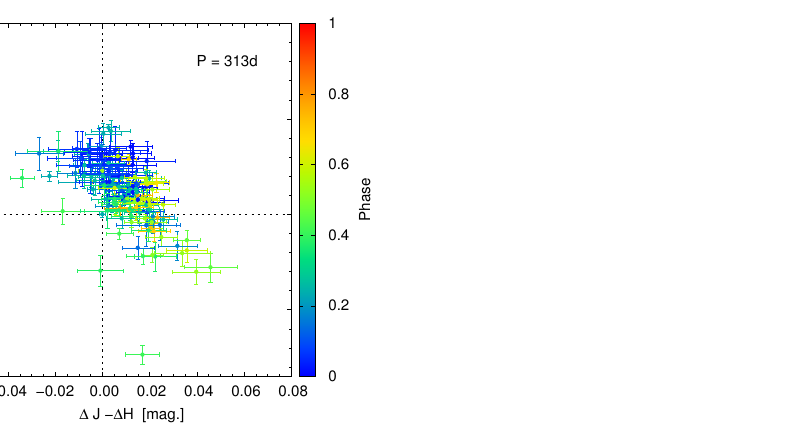
Figure 7. Color ( ∆ J − ∆ H )–magnitude ( ∆ J ) diagram for HESS J0632 + 057 by IRSF/SIRUIS. The color indicates the phase φ , calculated for the orbital period of 313 days.